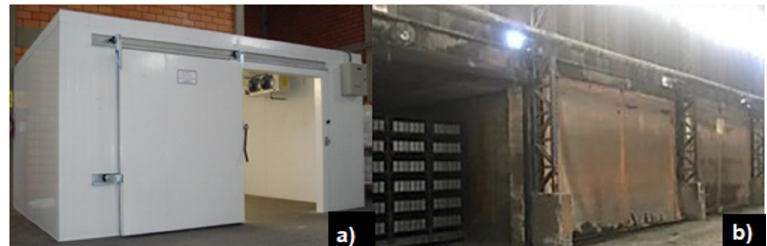
Figure 12. Proposal for carbonation chambers: a) new installation; b) retrofit. Source: Author